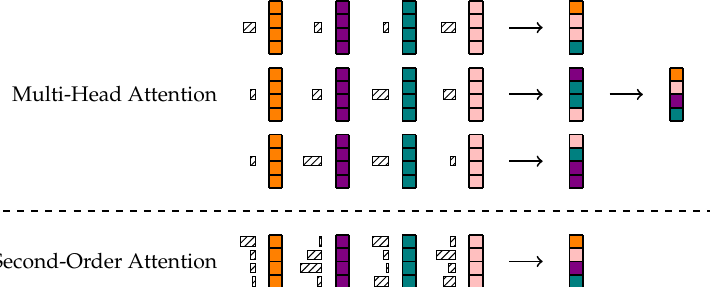
Figure 2. Scalar attention requires the use of different sets of attention parameters—heads—to attend to different features of the tokens being aggregated; vector attention allows features to be weighted